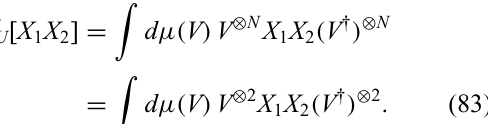
FIG. 10. Comparison of the equivariant and the nonequivari- ant ansätze for the Heisenberg model on N = 10 spins. For every number of layers p , we perform 20 experiments with random ini- tializations of the parameters and plot the difference between the mean achieved energy and the ground state energy (top) the num- ber of iterations necessary to reach it (bottom). We see that, for large enough p , the equivariant ansatz performs better in both figures of merit. For p small, however, the approximation to the ground state is